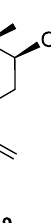
Figure 7. Stereoisomers of limonene.